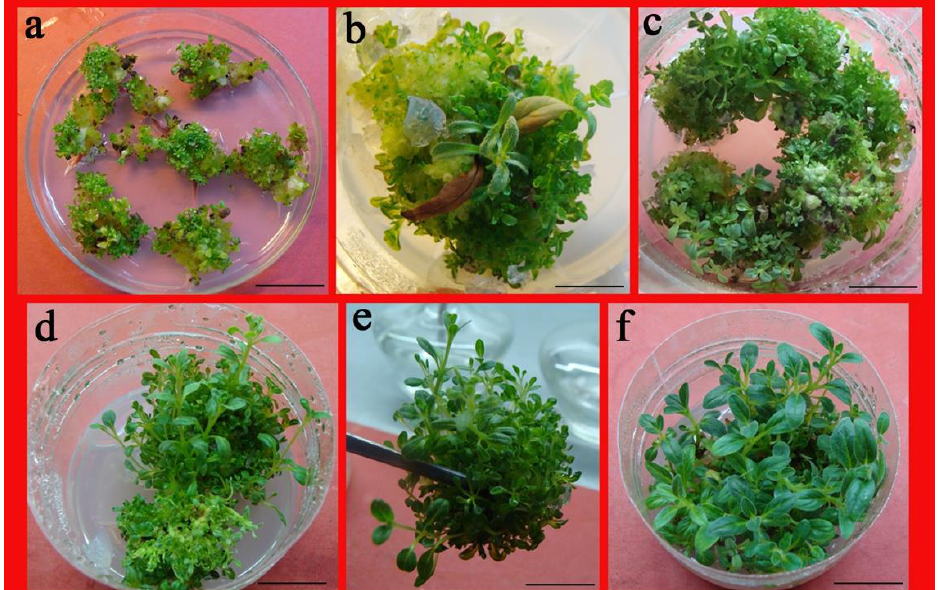
Figure 4. Callus-mediated plant regeneration from A. lupulina shoot tip explants on medium inclusive of 2.0 mg L −1 BA and 0.01 mg L −1 NAA. ( a ) Callus differentiation and bud initiation from shoot tip (Chopped) tissue for 3 weeks; ( b , c ) Prolific adventitious shoot development from light-green callus for 5 weeks. ( d , e ), Increasingly proliferated and differentiated shoot for 6 weeks. ( f ) Cultures grown for 7 weeks with robust shoots ready for rooting. Bar = 2 cm ( a , c – f ), 2.5 cm ( b ). Table 3. Effect of PGRs on induced organogenesis from shoot tip of A. lupulina . Shoot Proliferation Treatment (mg L −1 ) Callogenesis (%) Observed Results Coefficient Control 0 b 0 c Nil Light-green callus; Soft and NAA 0.01 + TDZ 2.0 100 a 25.4 ± 2.2 a fragile; Dwarf shoot Light-green callus; Soft and NAA 0.01 + 6-BA 2.0 100 a 18.5 ± 3.7 b fragile; Robust shoot